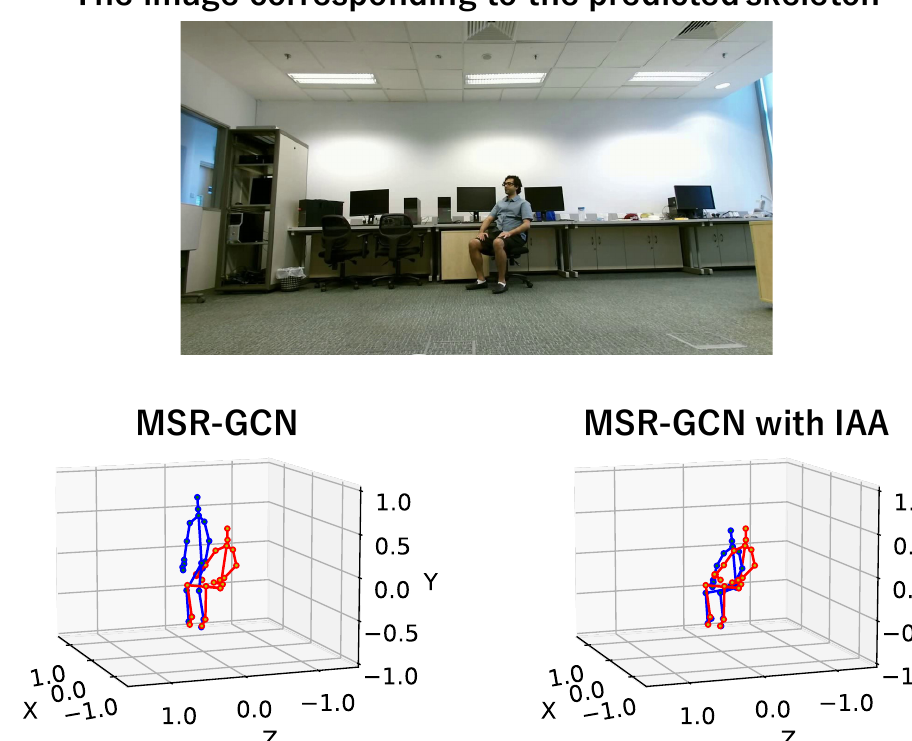
Figure 9. A prediction example of the 30th frame of prediction (blue) and ground truth (red) in “sit down”. In this example, the existing method made the misprediction as “jump up”, but our proposed method predicted it correctly. In object-related motions, the future skeleton is well predicted by our proposed